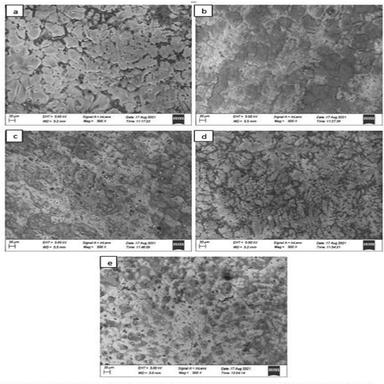
SEM Images (a) AZ31 alloy, (b) AZ31-0.5 B4C, (c) AZ31-1.0 B4C, (d) AZ31-1.5 B4C and (e) AZ31-2.0 B4C.